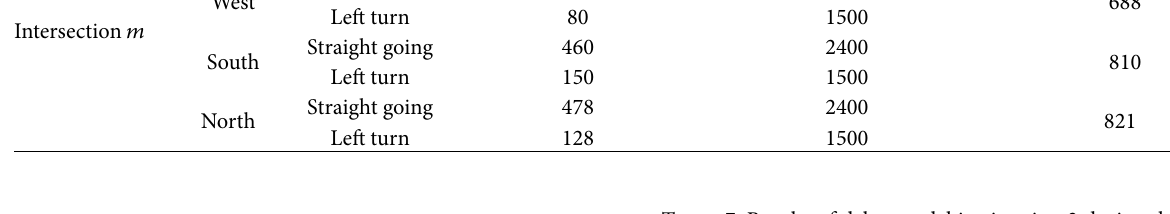
Table 7: Results of delay model in situation 2 during the nonpeak period.